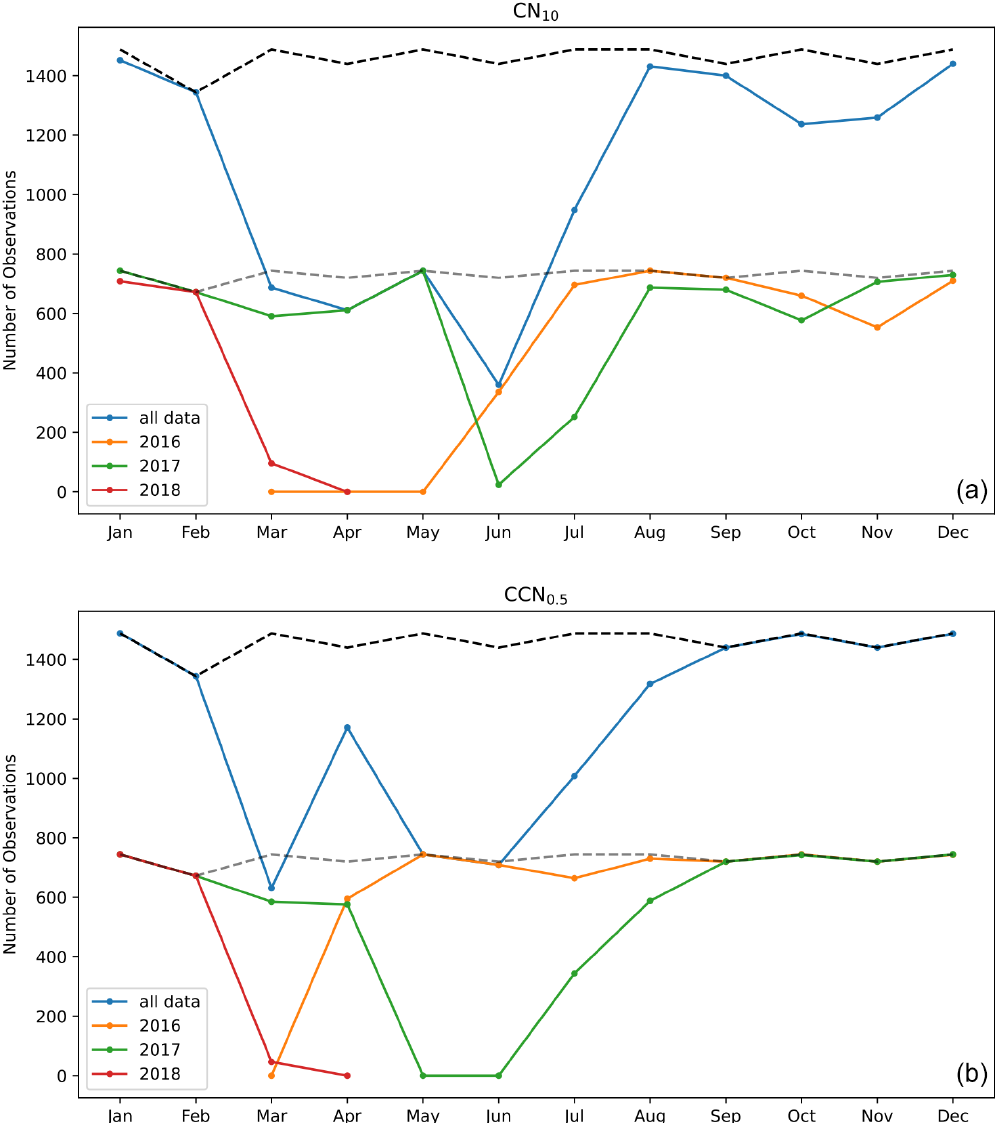
Figure A4. Number of hourly data points available per month from Macquarie Island during the 2 years for both CN 10 (a) and CCN 0 . 5 (b) . Data are shown for the full campaign and then separately for each year. The grey dashed line is a reference point for the maximum number of hours available in a particular month of each year, while the black dashed line is similar but for the maximum available during a particular month over the entirety of the